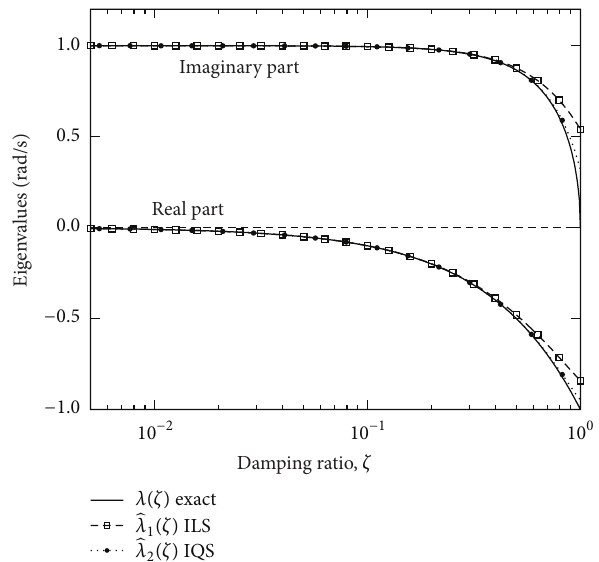
Figure 2: Eigenvalues of viscous model versus 𝜁 . Continuous line for exact values and dotted one for Improved Solutions: square tick for Linear (ILS) and bullet for Quadratic